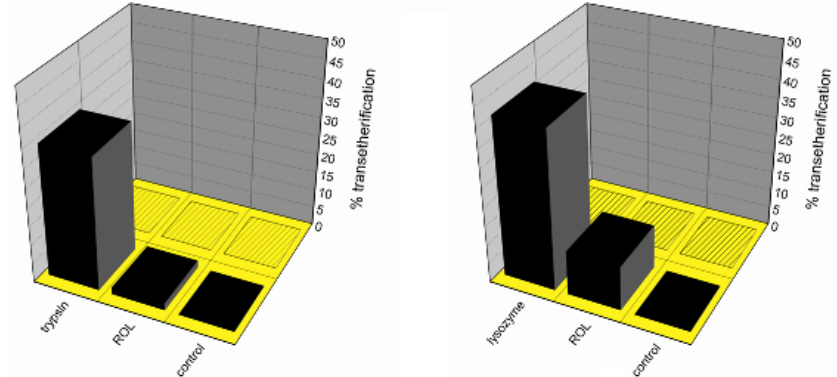
Figure 1. Enzyme-catalyzed transetherification and/or silanol alcohol condensation/exchange study between trimethylethoxysilane (left) or phenyldimethylethoxysilane (right) with 1-octanol (filled bars) or tert -butanol (bars with patterns), after 24 h at 25 